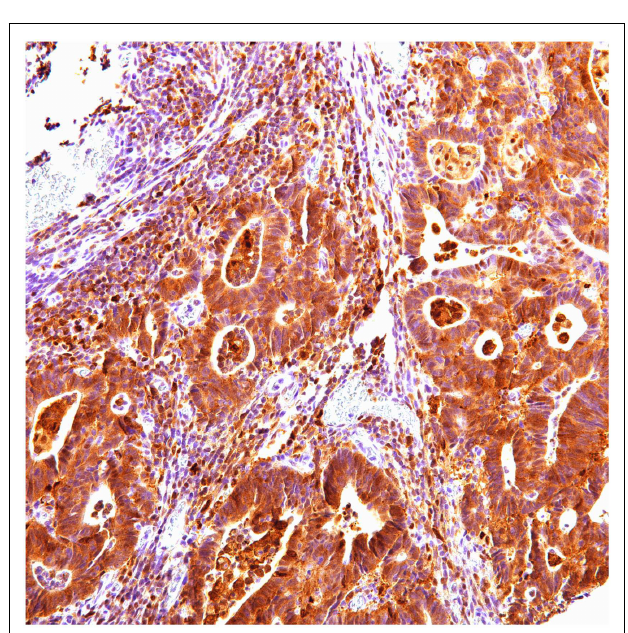
FIGURE 4 | P62 cytoplasmic positive in colon carcinoma